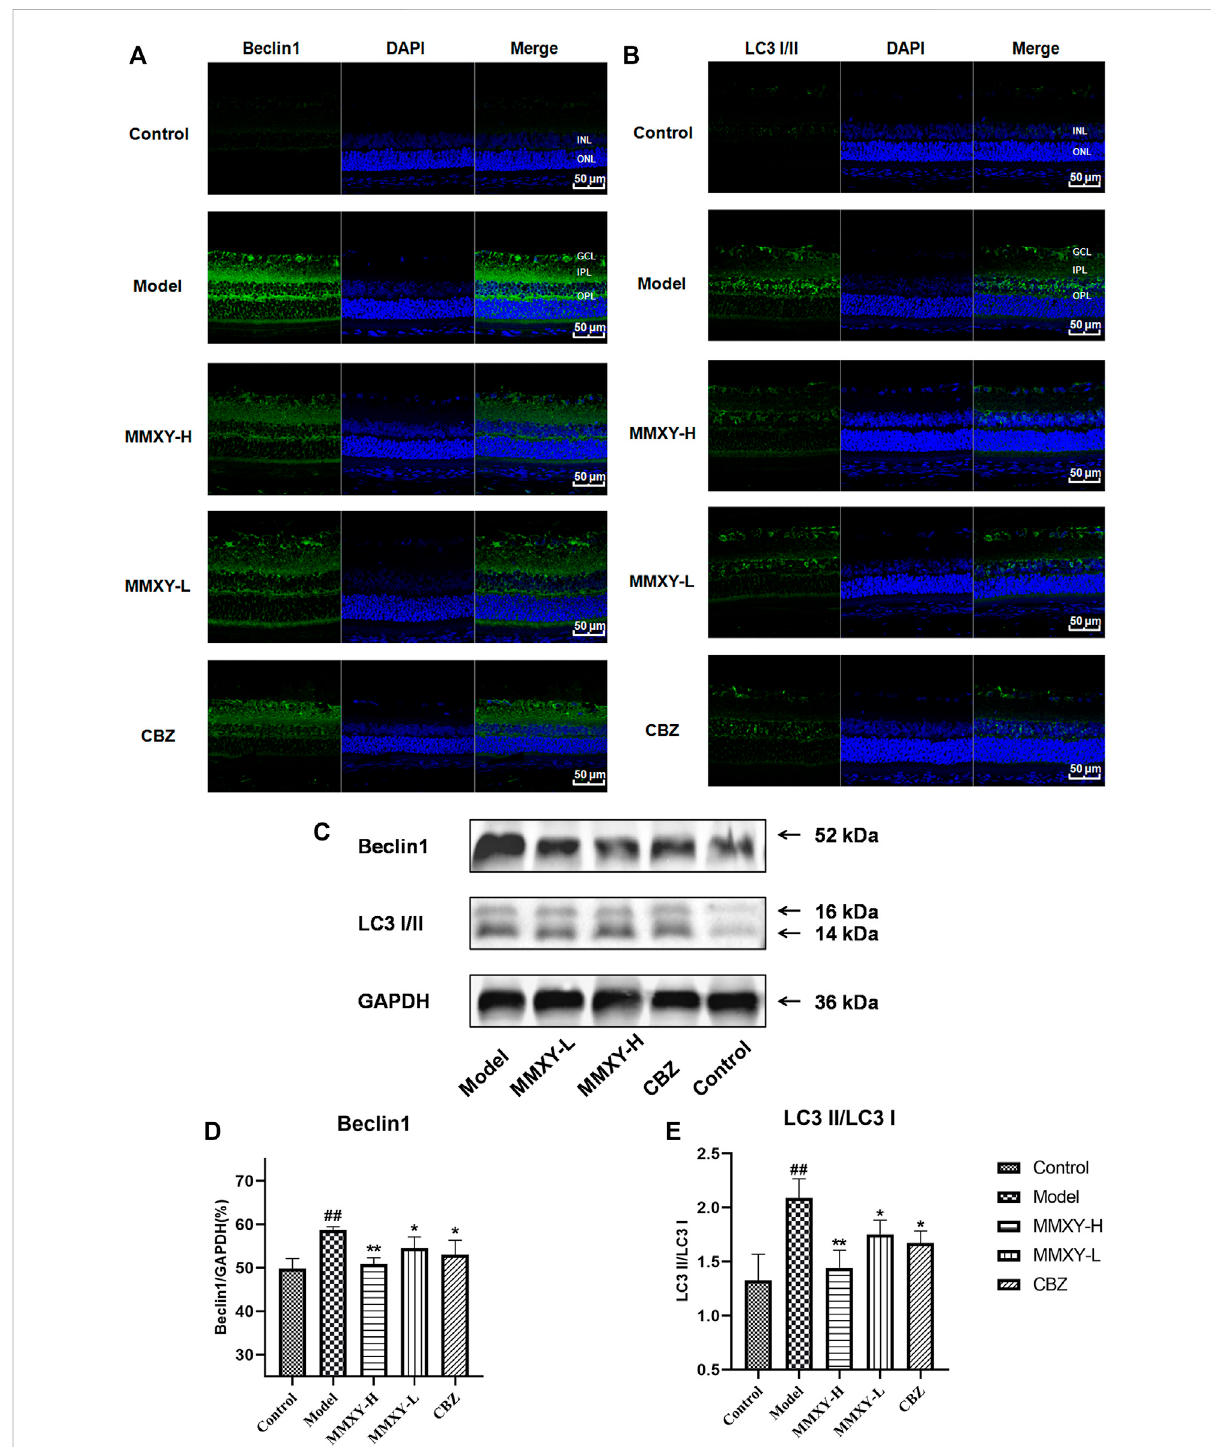
FIGURE 10 Effects of MMXY on retinal autophagy fl ux in CUMS rats (A,B) Immuno fl uorescence staining of Beclin1 (green), LC3 (green) and DAPI (blue) of retinas in each group. Scale bars = 50 µm. (C) Representative images of Western blot showing Beclin1 and LC3I/II expression in the retina of each group.GAPDHwasusedtocon fi rmanequalamountofprotein(n=3). (D,E) QuantitativeexpressionofBeclin1andLC3II/LC3Iineachgroup.Results are shown as the mean ± SD (n = 3). # p < 0.05 and ## p < 0.01 vs. control group; * p < 0.05 and ** p < 0.01 vs. model